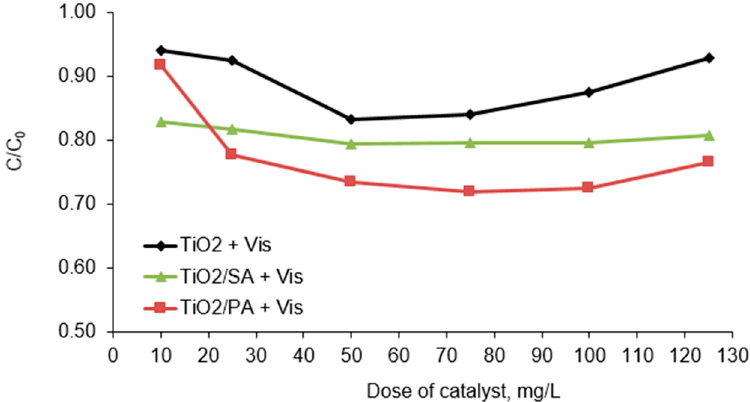
Figure 5. Decomposition degree of chlorfenvinphos in the presence of the selected catalysts. Conditions of experiment: C 0 = 1.0 mg/L; V r = 500.0 mL; t ir = 60.0 min; pH = 6.0.